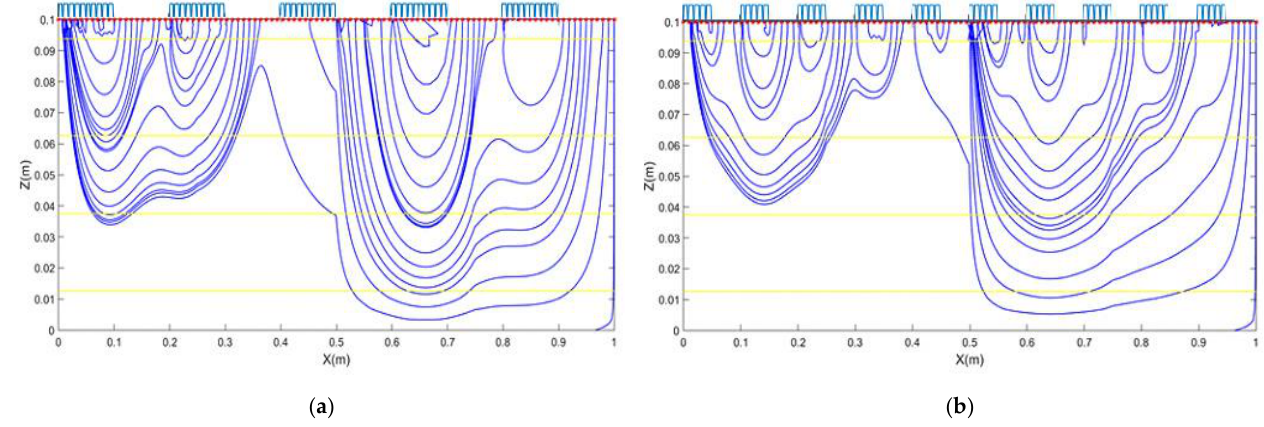
Figure 15. Distribution of streamlines for model set ups zgst5 × 10-5 ( a ), zgst5 × 10-50 ( b ). The figure illustrates the effect of change in distribution of gravel and sand portion of streambed over streamline distribution.